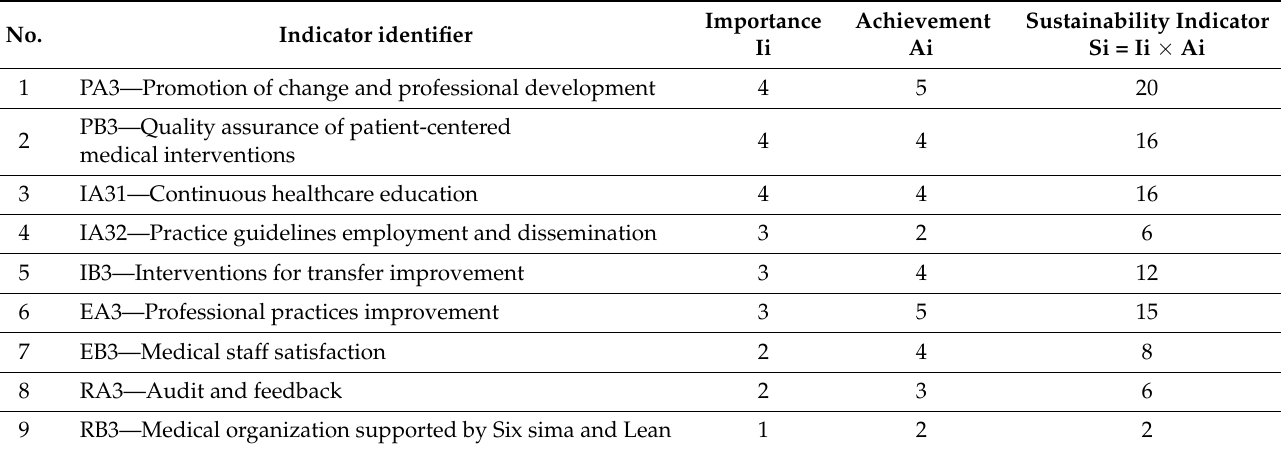
Table 2. Self-evaluation instrument for labor practices